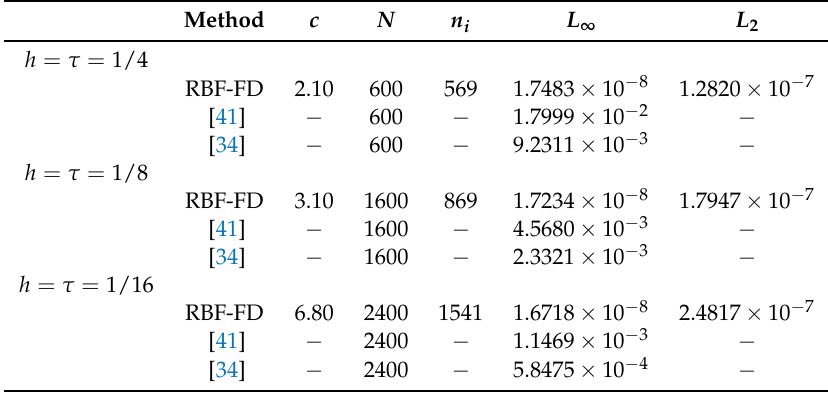
Table 4. The L ∞ and L 2 errors under different mesh steps h = τ at T = 40 for Example